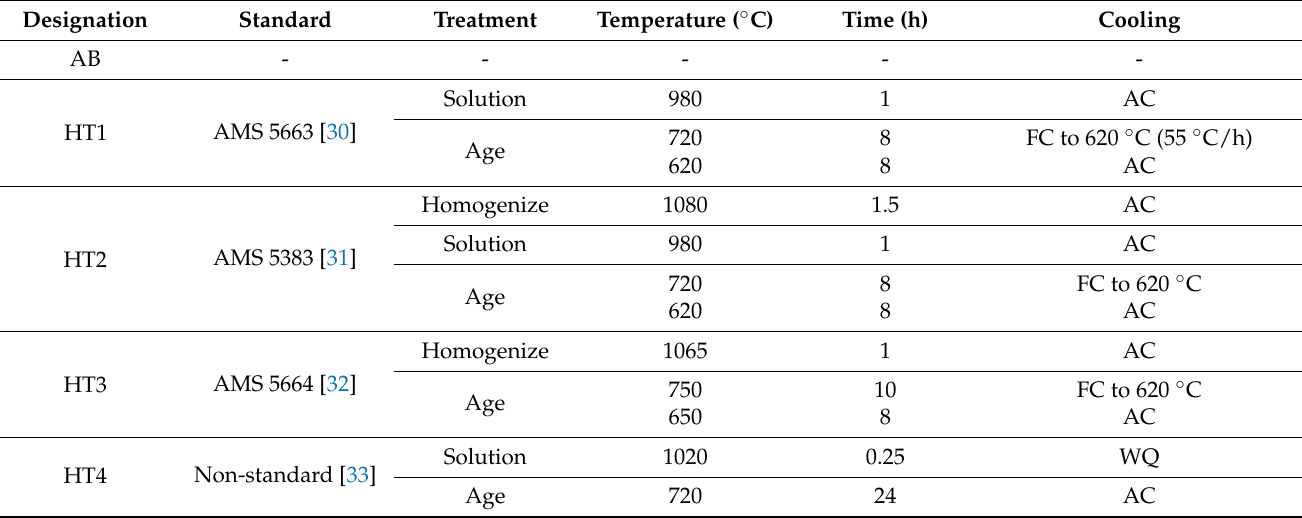
Table 2. Summary of the specimen conditions and applied heat